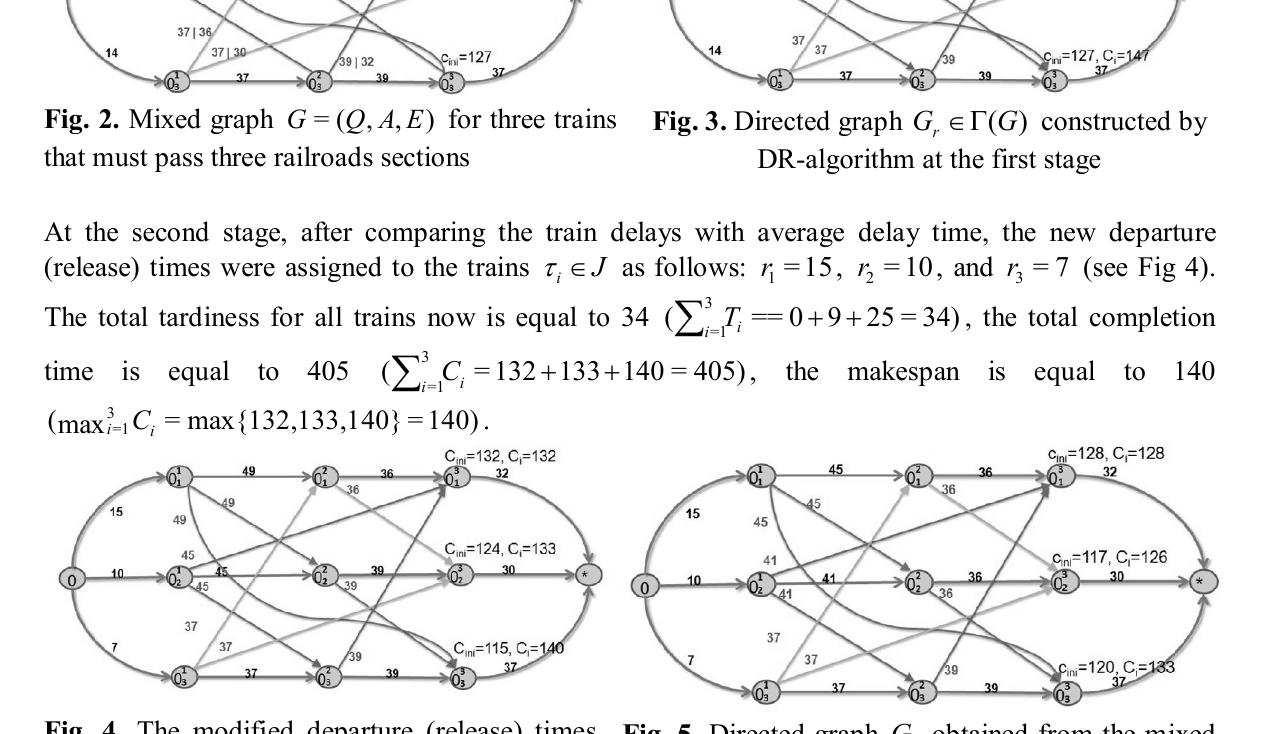
G obtained from the mixed s graph G due to rescheduling based on the